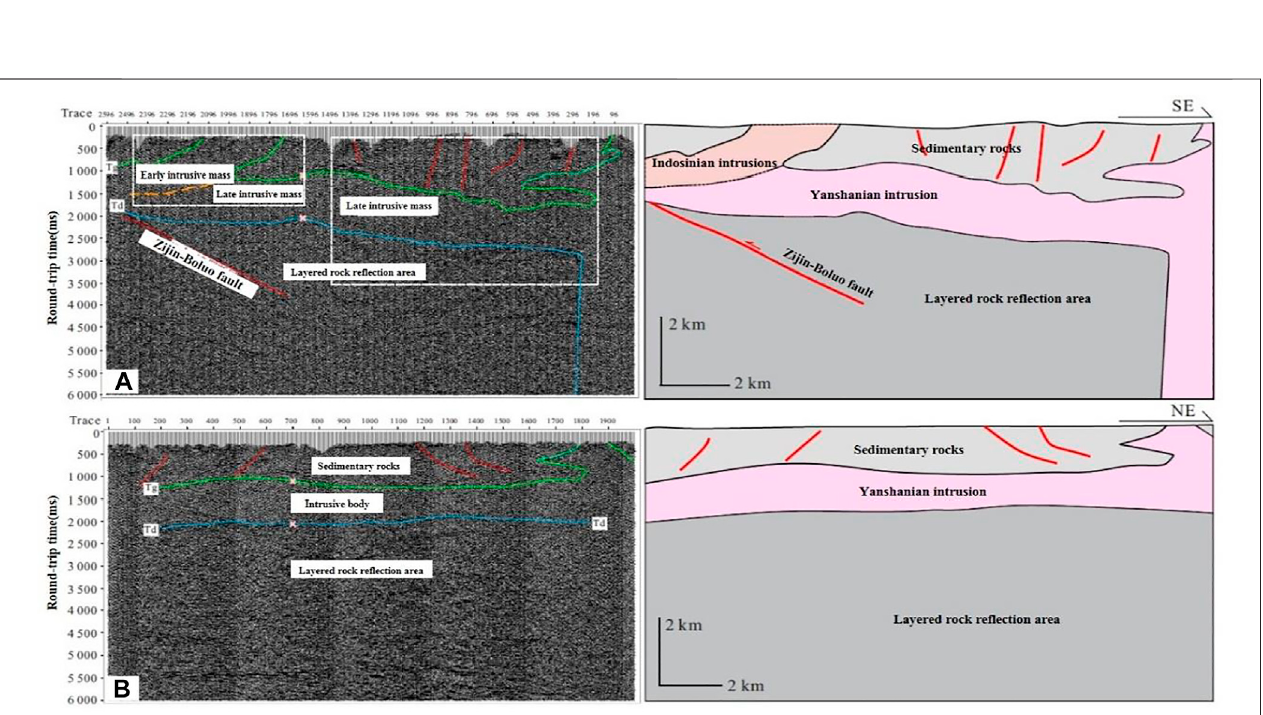
FIGURE 10 | Pro fi les of seismic inversion, (A), (B) and its geological interpretation in Huangshadong area (Kuang et al., 2020).